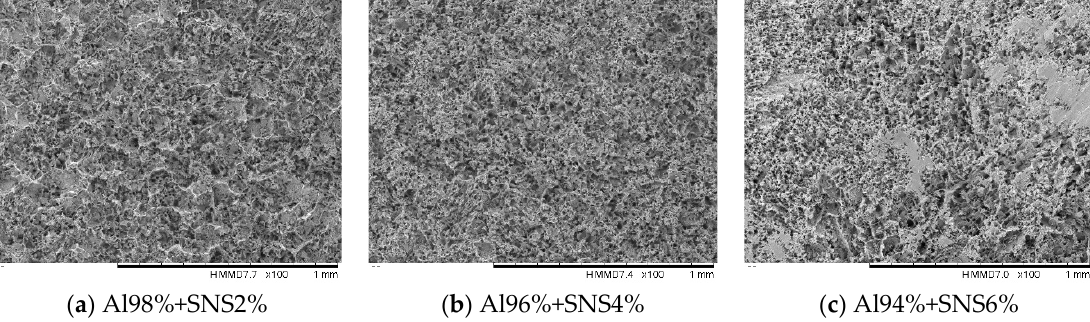
Figure 8. SEM images of the investigated samples after corrosion tests.